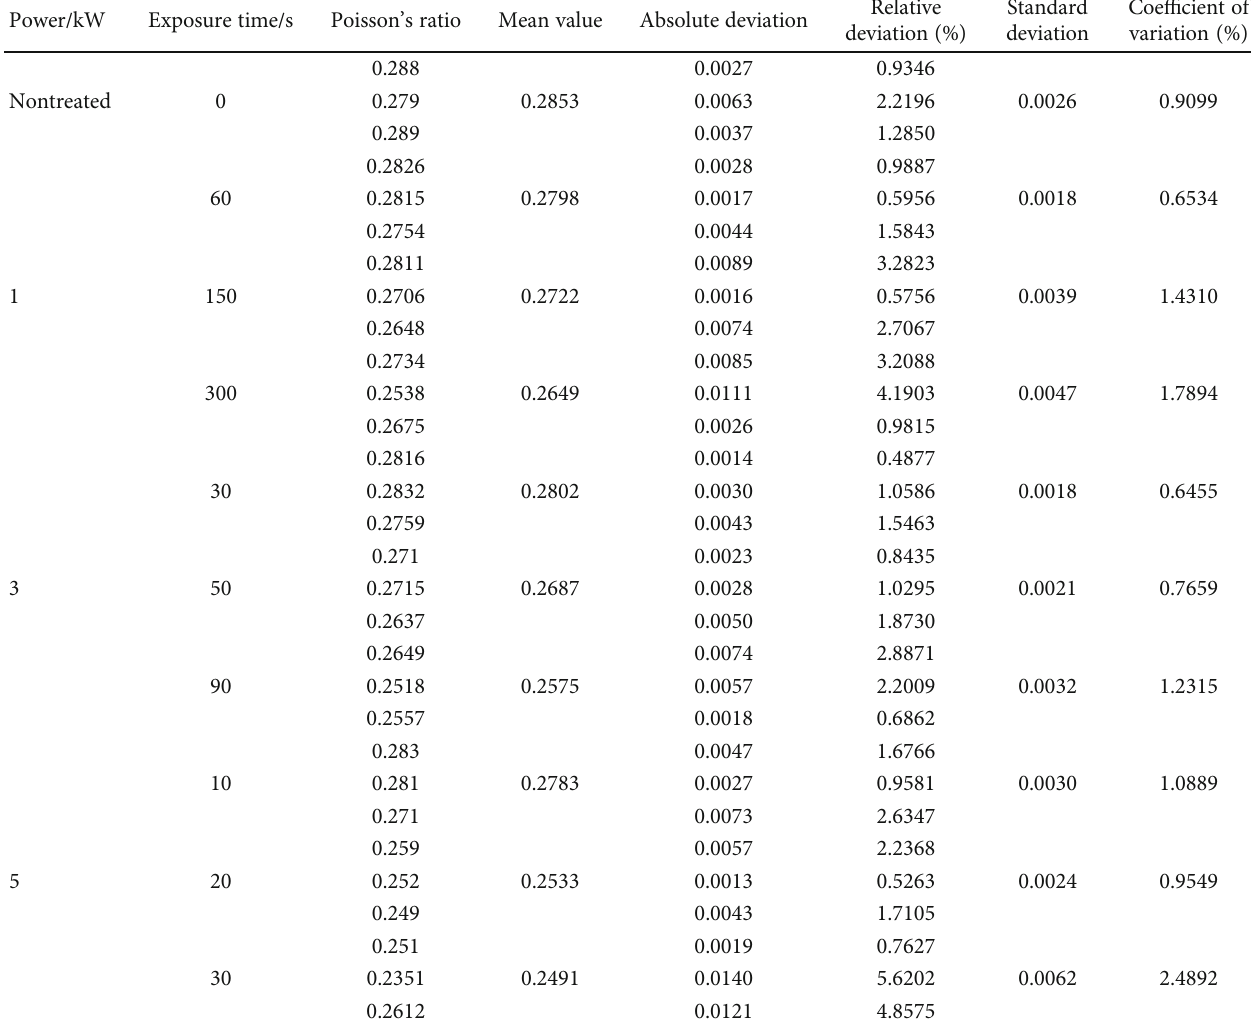
Table 6: Testing results of Poisson ’ s ratio induced by microwave